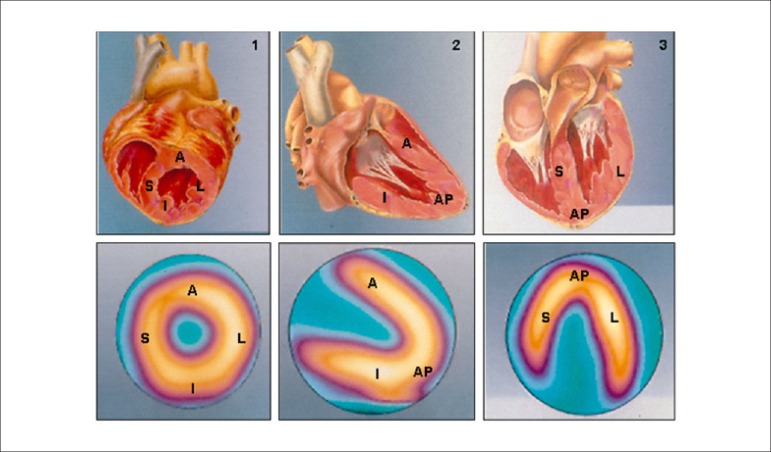
Two-dimensional reconstruction of scintigraphy images representing normal perfusion patterns (lower images), in line with minor axis (1), vertical long axis (2), and horizontal long axis (3) cross sections and their respective corresponding anatomical cross sections (upper images). A: anterior; AP: apical; I: inferior; L: lateral; S: septal. Adapted from Mastrocola LE.195